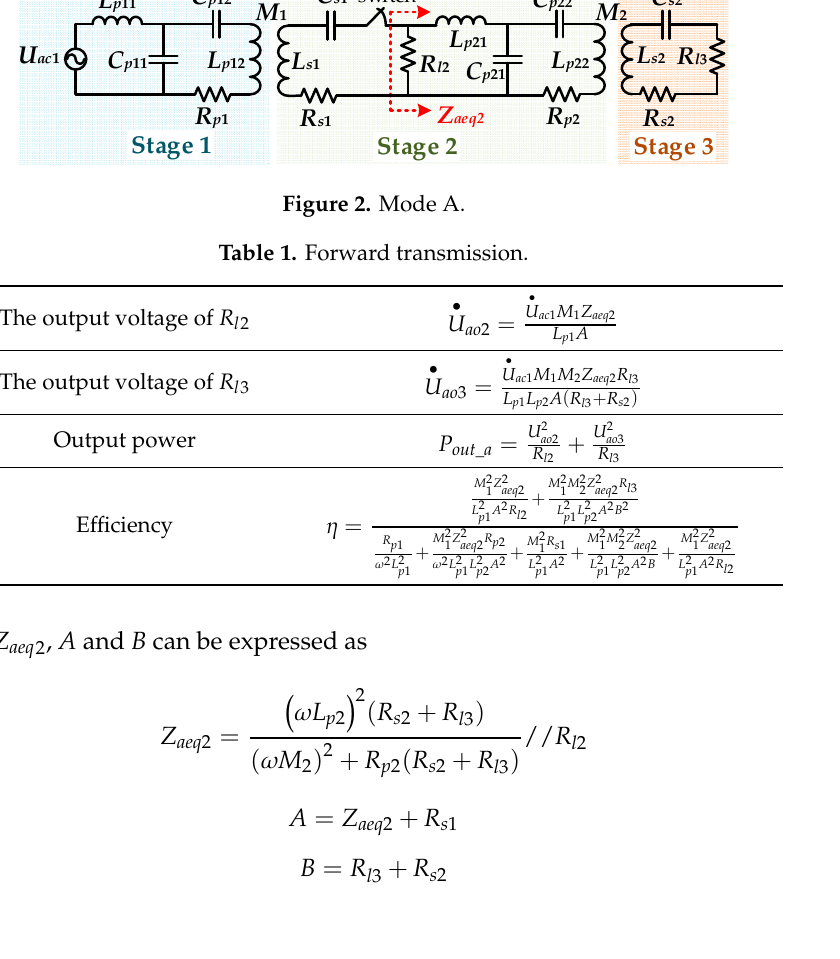
Stage 3 Figure 3. Mode B. Table 2. Reverse transmission.